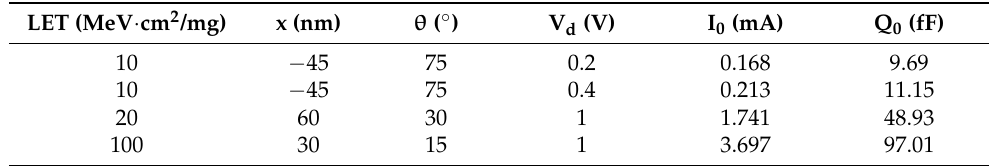
Figure 5. The network structure for predicting transient current peaks and total collected charges. Table 3. Partial data of network training and